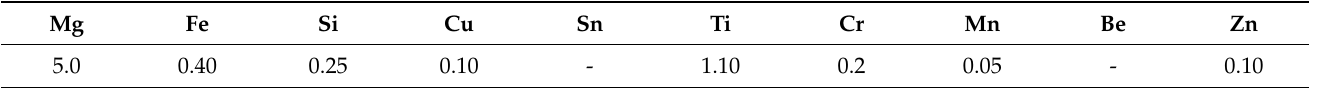
Table 1. Chemical composition of the 5356 aluminum alloy